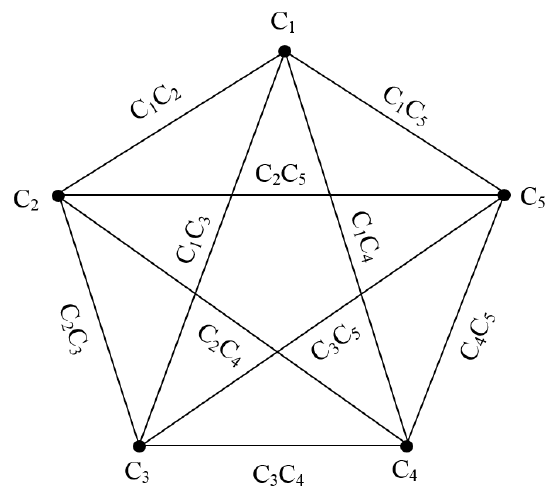
Figure 15. Complex intuitionistic fuzzy graph with